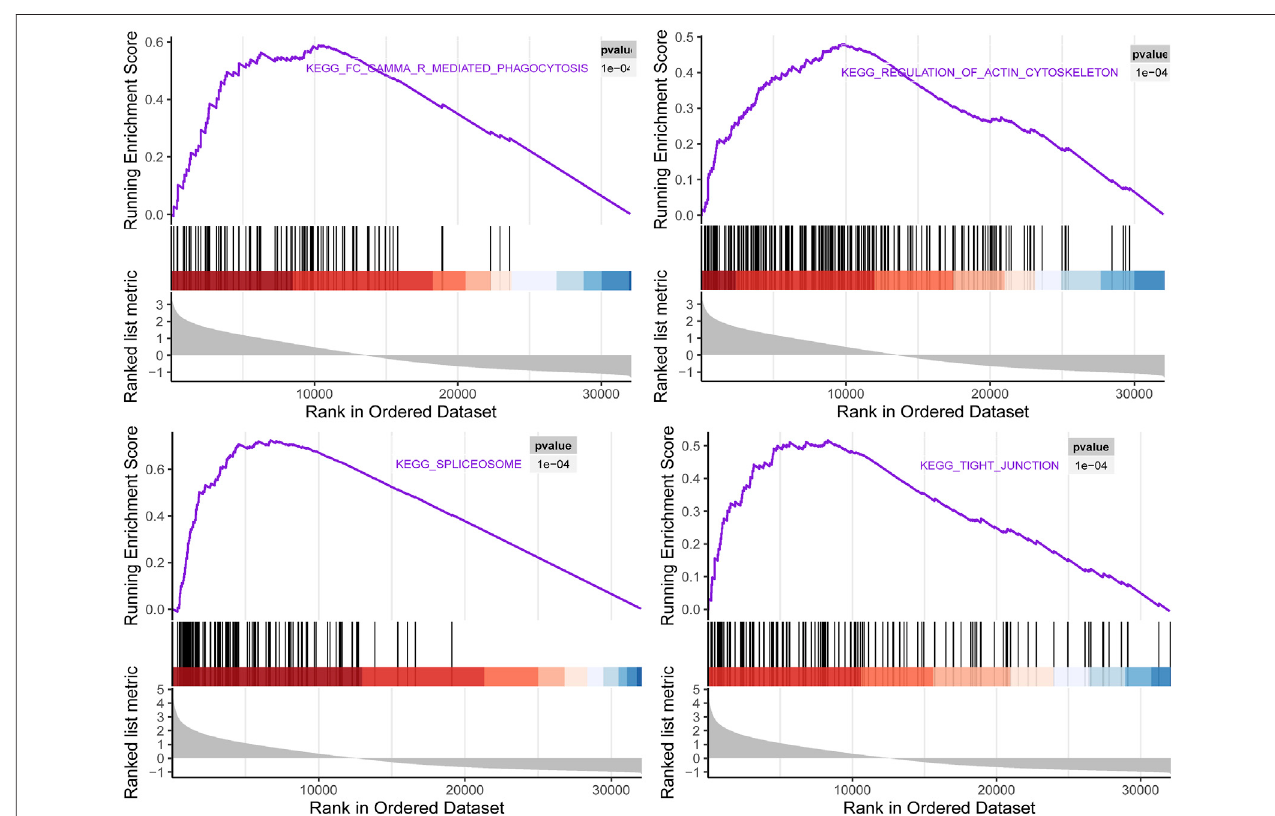
FIGURE 10 | Gene set enrichment analysis (GSEA) using GSE116959 showed a positive enrichment of identi fi ed hub genes associated with four Kyoto Encyclopedia of Genes and Genomes(KEGG) pathways.